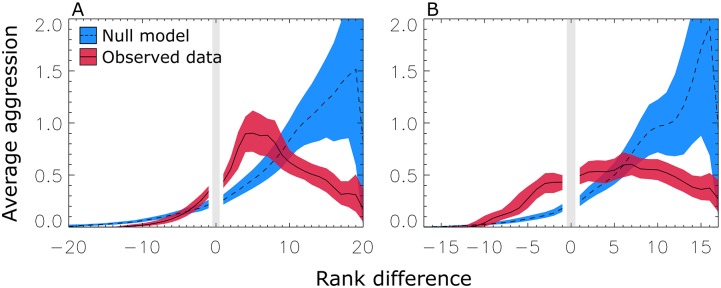
Structured aggression.Preferential rank aggression (R(Δ), Eq 3) pooled over the final 3 quarters of the study period for Group One (a) and Group Two (b). Pooling data provides a gain of signal-to-noise that further refines our understanding of the strategies at work once the behavior-knowledge feedback is in place. Both groups show a focusing of aggression towards those nearby in rank, over and above null expectation. Higher levels of rank entrepreneurship—aggression directed, contrary to expectation, upwards in the hierarchy—are visible in Group Two. Points are averaged ±1 rank; bands are 1σ bootstrap-estimated error ranges.